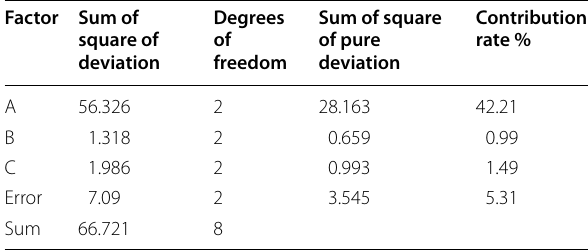
Table 18 Contribution results of factors and errors under the 73 d compressive strength Factor Sum of square of